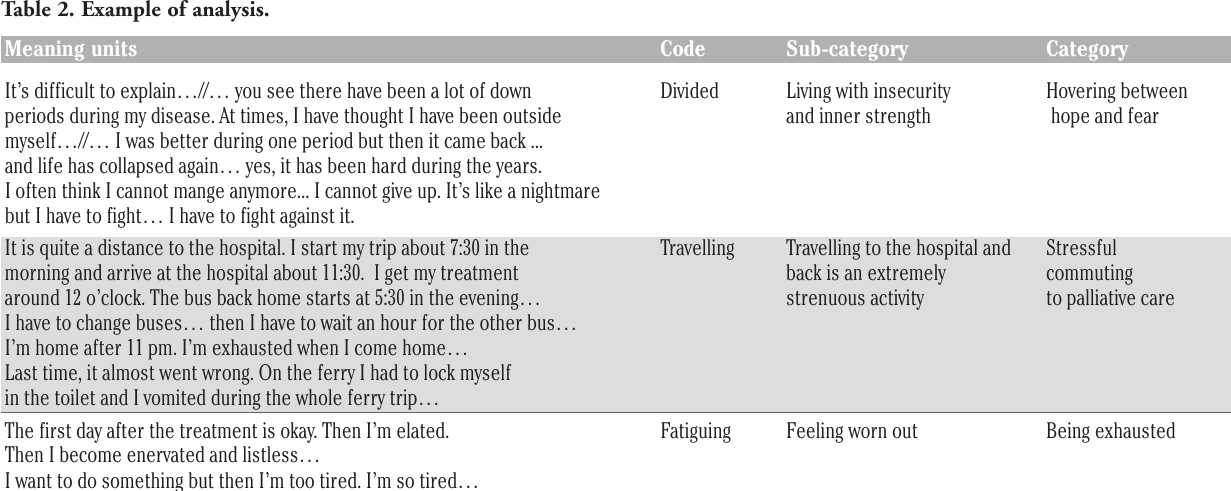
Table 2. Example of